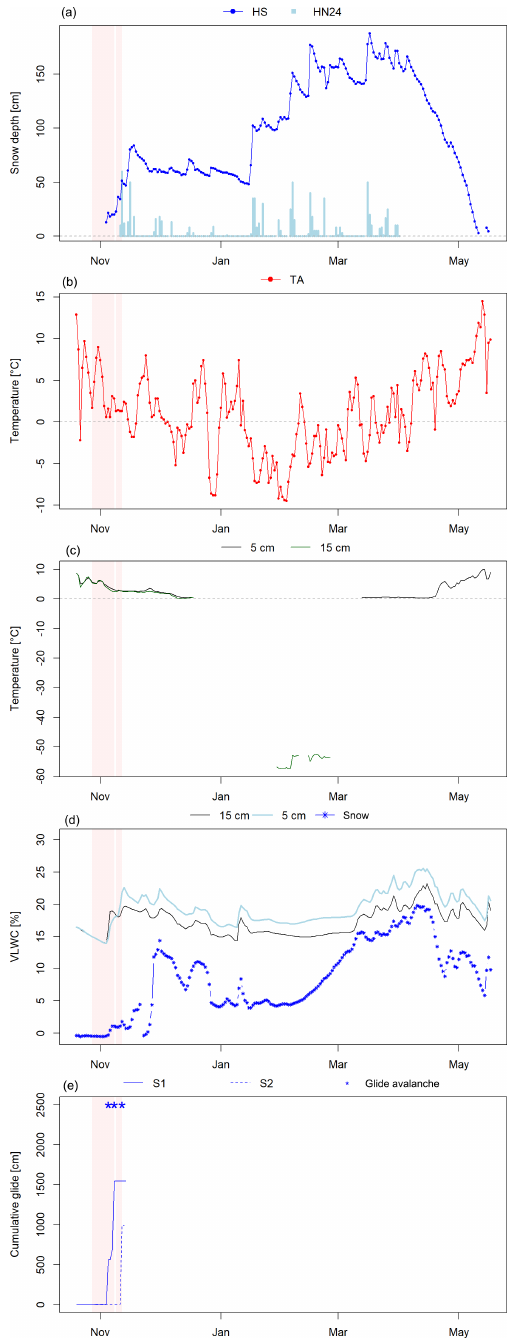
Figure 7. Site Sant’Anna, winter season 2014–2015: (a) snow depth (HS) from AWS Weissmatten and new snow sum (HN24) from manual snow measuring site Gabiet, (b) air temperature (TA) from AWS Weissmatten, (c) soil temperature, (d) VLWC measured within the soil and in the basal snowpack layer, (e) cumulative glide. Warm and cold periods are highlighted in orange and blue, respec- tively; periods reported in white are periods of no data analyses for S1, S2 or both (see Table 1 for details) (from 1 December 2014 to the end of the season there are no analyses for